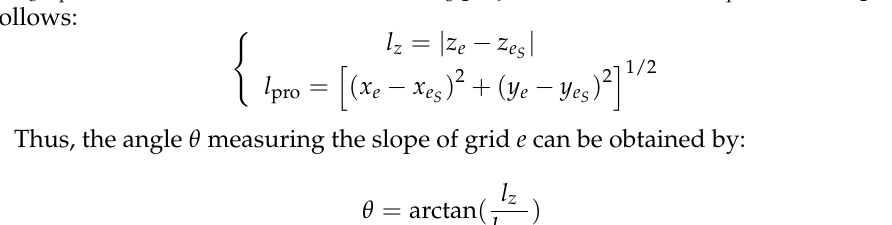
Figure 3. ( a ) Schematic of the elevation points relative to S fit . ( b ) Schematic of the relative position of S fit with respect to S dat